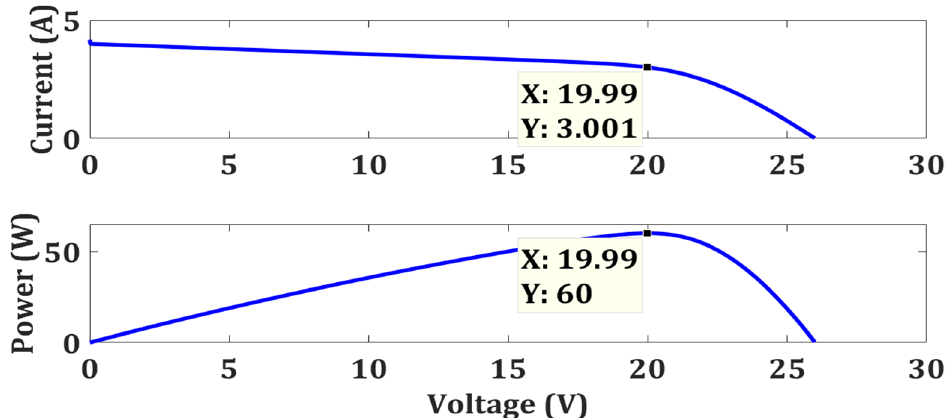
Figure 31. Characteristic curves of 2S PV system for test case 1.